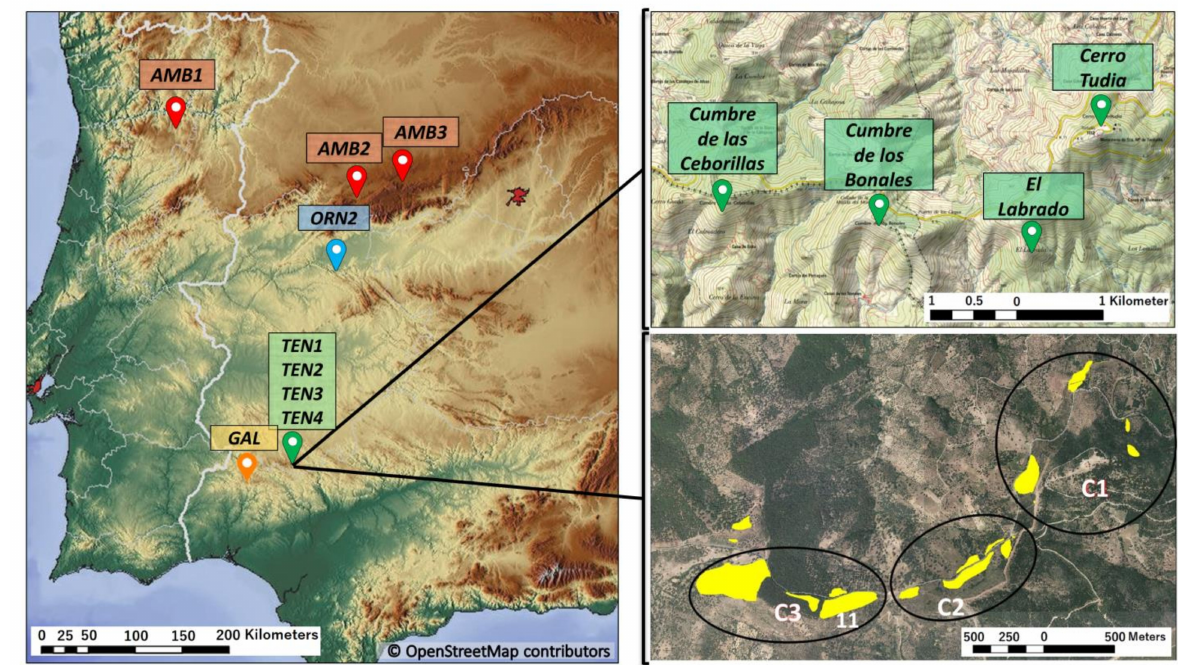
Figure 1. Map of south-western Iberian Peninsula (left) with the sampling points. The maps on the right shows, on top, the locations sampled on Sierra de Tudia; green location symbol, sampled individuals for DNA sequencing; at the bottom, the yellow shadow represents the sampled area for allozymes (which approximately corresponds to the species range), with the three subpopulations indicated; C1: Cerro Tudia, C2: El Labrado and C3: Los Bonales. Data of the population codes are shown in Table S1. Maps were obtained from www.maps-for-free.com, www.geamap.com (15 November 2020), and the National Geographic Institute (15 November 2020).